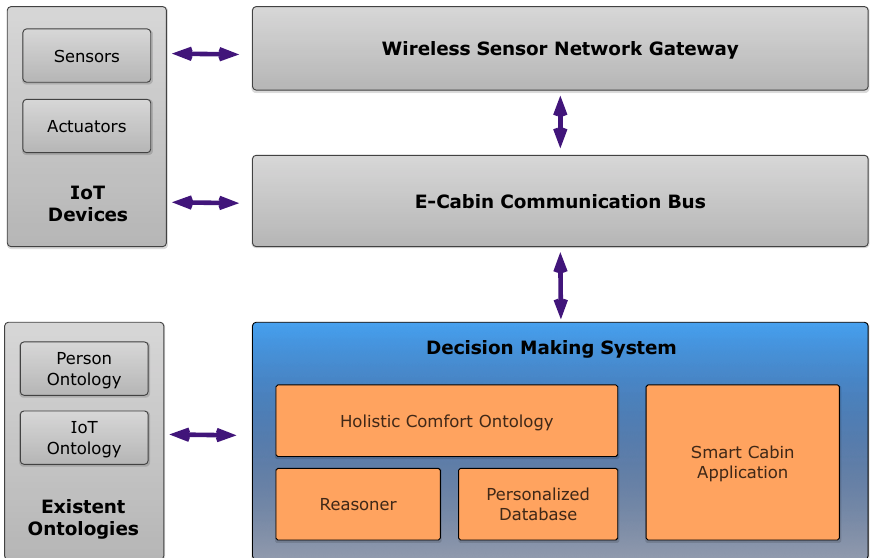
Figure 1. General architecture of the proposed reasoning